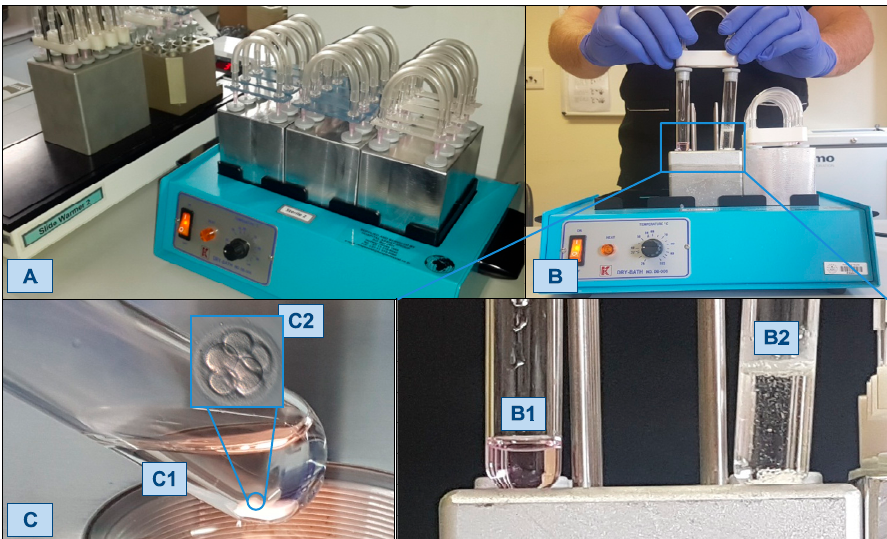
Figure 1. The ‘simplified culture system’ (SCS) performs IVF relaying on a self-contained, air-tight closed environment composed of two standard plain glass medical grade culture tubes connected by catheter tubing ( A , B ). One tube serves as a CO 2 generator through an effervesce reaction be- tween sodium bicarbonate and citric acid releasing sufficient CO 2 ( B2 ), while the other tube con- tains ‘single-step’ culture medium equilibrating to an atmosphere and pH (between 7.29 and 7.35). With the correct pH, the culture medium shows a pink colour ( B1 , C1 ). With a stereoscopic micro- scope, the embryo can be observed through the glass wall of the vacutainer ( C2 ). The SCS system is consistent with human IVF provided that the tube is kept at 37 °C during fertilization and further embryo culture.